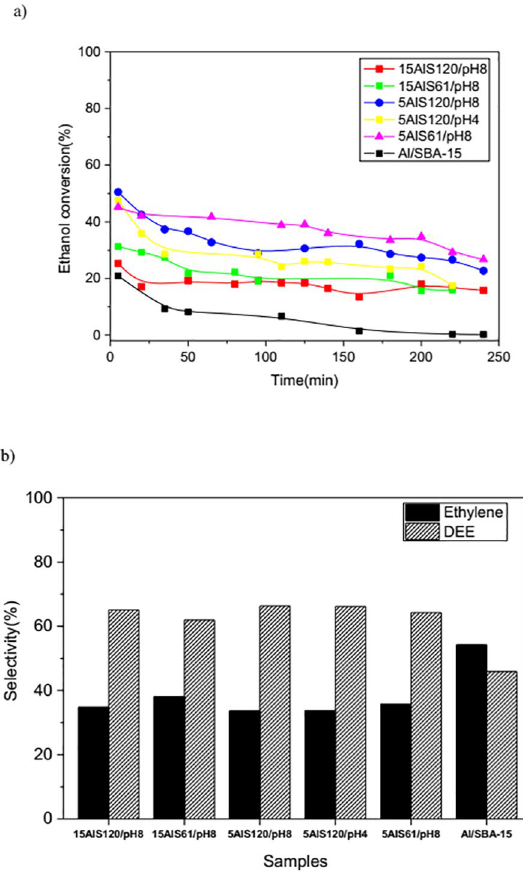
Figure 6. Graphics of ethanol conversion and product selectivity in a) ethanol conversion as a function of time at 250 °C of samples and b) product selectivity at 250 °C.